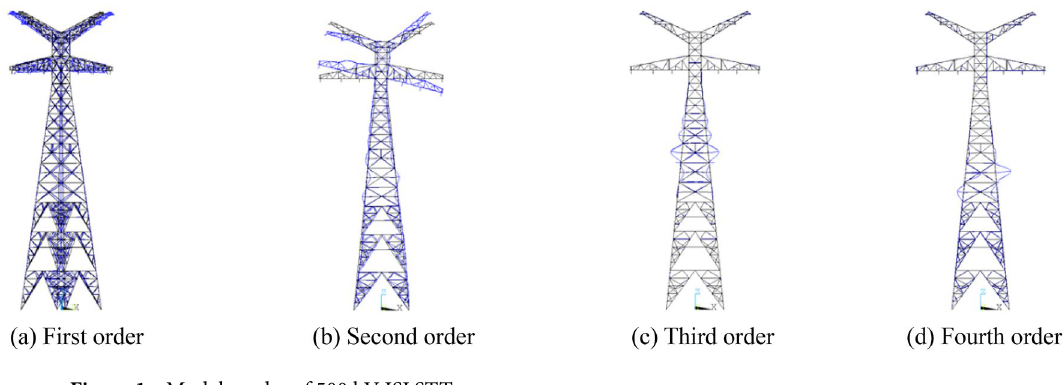
Figure 1. Modal modes of 500 kV